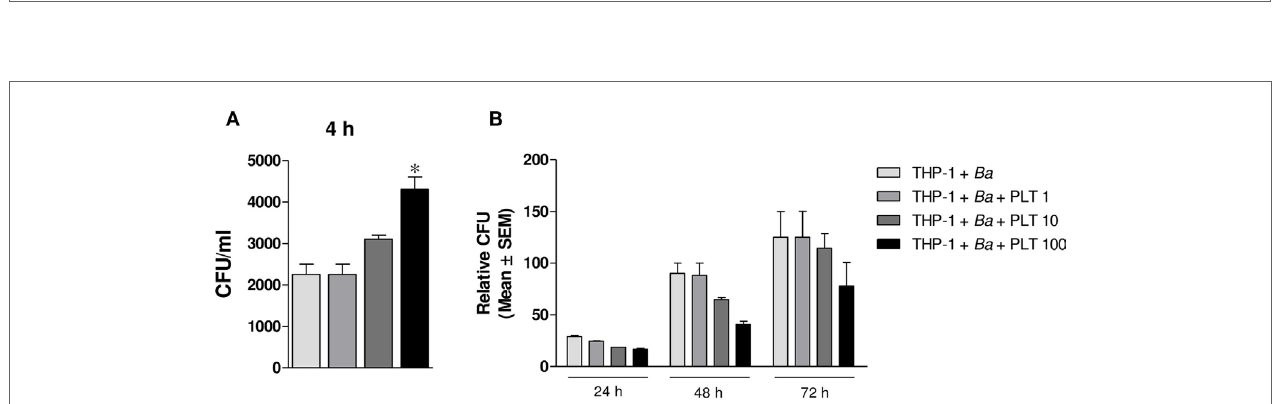
FigUre 8 | Soluble factors released by platelets mediate the modulation of surface molecules on monocytes. THP-1 cells were stimulated with supernatants collected from platelets incubated in presence or absence of Brucella abortus and assessed by flow cytometry. Monocyte population was identified in a FSC vs. SSC dot plot (a) and the CD54 surface expression was quantified within this region (B) . Supernatants from bacteria cultured alone were used as control. Bars represent the arithmetic means ± SEM of three experiments. MFI, mean fluorescence intensity. THP-1 cells were incubated with supernatants of B. abortus - stimulated platelets in presence or absence of neutralizing Ab to soluble CD40L (sCD40L) (c) or platelet factor 4 (PF4) (e) . THP-1 cells were stimulated with sCD40L (D) , PF4 (F) , or platelet-activating factor (PAF) (g) in their recombinant forms. (h) THP-1 cells were treated with supernatant collected from B. abortus -stimulated platelets in presence or absence of aspirin. (i) THP-1 cells were stimulated with a combination of sCD40L, PF4, and PAF. (J) THP-1 cells were treated with supernatant obtained from B. abortus -stimulated platelets in presence or absence of aspirin plus anti-sCD40L and anti-PF4 neutralizing antibodies. In all cases, CD54 surface expression was assessed by flow cytometry after the different treatments. Bars represent the times of CD54 induction ± SEM of three experiments. **